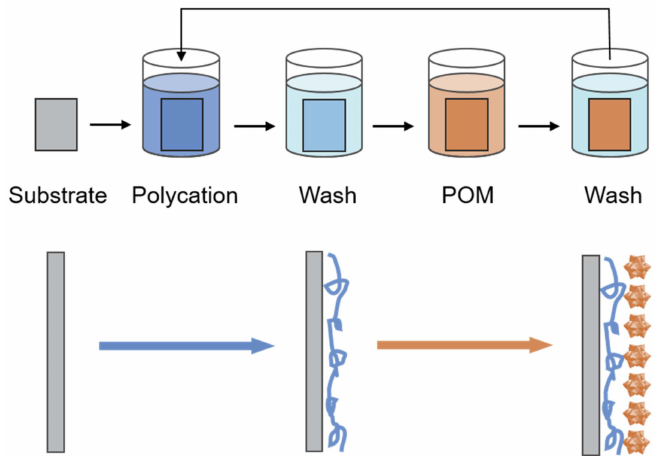
Figure 3. Schematic illustration of the fabrication procedure of POM-based multilayer films by layer-by-layer (LBL) self-assembly. Reproduced with permission from [66]. Copyright (2012) The Royal Society of